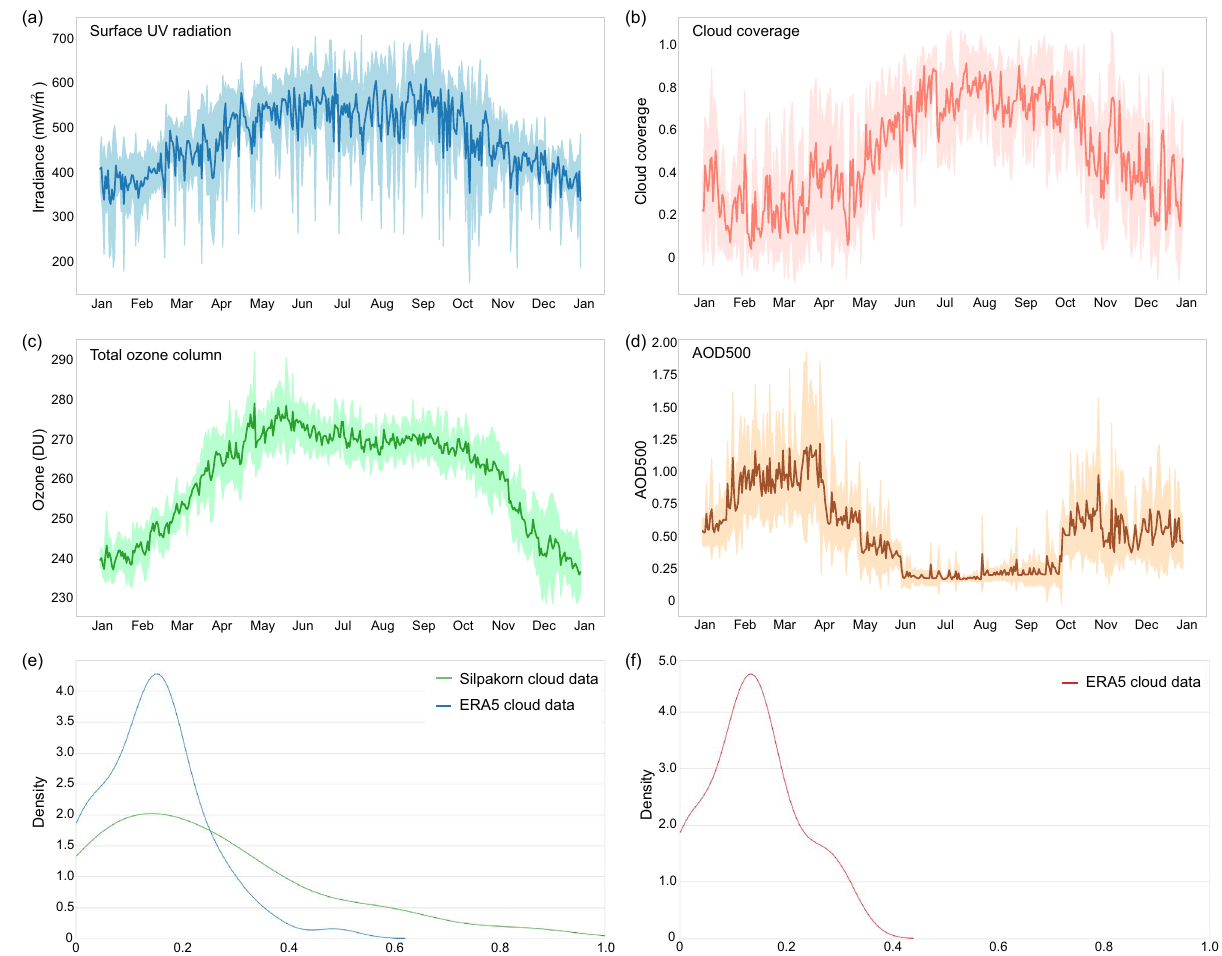
Figure 1. Characteristics of UV and weather conditions at Nakhon Pathom, Thailand. Daily maximums are shown for UV irradiance, total ozone column, and AOD500. Daily averages are shown for cloud coverage. Dark lines indicate the average across 2009–2017. Shaded areas indicate the ± 1 standard deviation range. ( a ) Annual surface UV irradiance. ( b ) Annual cloud coverage. ( c ) Annual total ozone column. ( d ) Annual AOD500. ( e ) The distribution of cloud coverage in the validation set (UV data from year 2018). Both Silpakorn University’s observations and ERA5 data were shown. ( f ) The distribution of cloud coverage in test set (UV data from year 2019). Information from Silpakorn University is